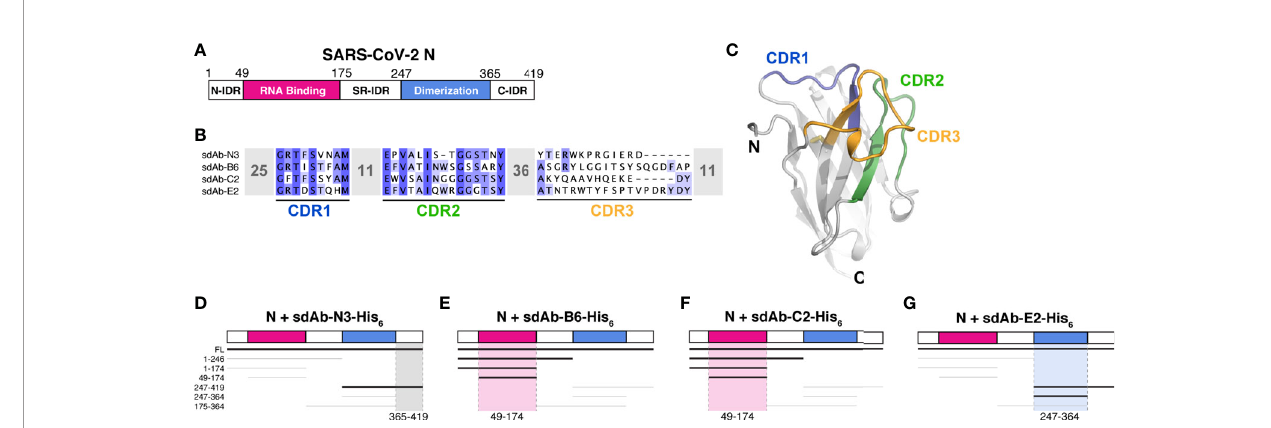
FIGURE 1 | sdAbs target individual domains of the SARS-CoV-2 N protein. (A) Domain schematic of SARS-CoV-2 N, with the RNA-binding domain in magenta, the dimerization domain in blue, and the three intrinsically disordered domains (N-IDR, serine/arginine rich (SR)-IDR, and C-IDR) in white. (B) Sequences of four sdAbs targeting the SARS-CoV-2 N protein (18, 19) showing the variable sequences within the Complementarity-Determining Regions (CDRs). (C) Example sdAb structure (sdAb-B6 shown) with complementarity-determining regions (CDR) 1, 2, and 3 colored blue, green, and orange, respectively. (D – G) Summary of Ni 2+ pulldown assays using C-terminally His 6 -tagged sdAbs and seven truncations of SARS-CoV-2 N (see Supplementary Figure 1 ). Thick lines indicate a positive interaction; highlighted regions indicate inferred region of SARS-CoV-2 N targeted by each